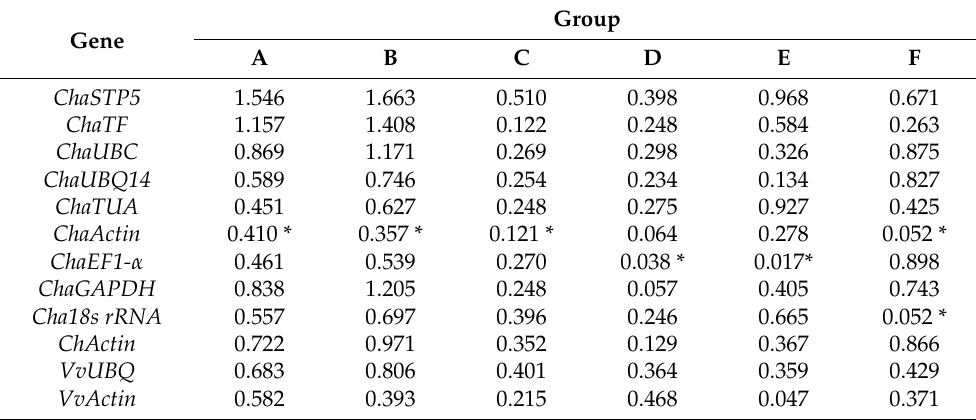
Table 4. Stability values for candidate reference genes generated using NormFinder. Gene